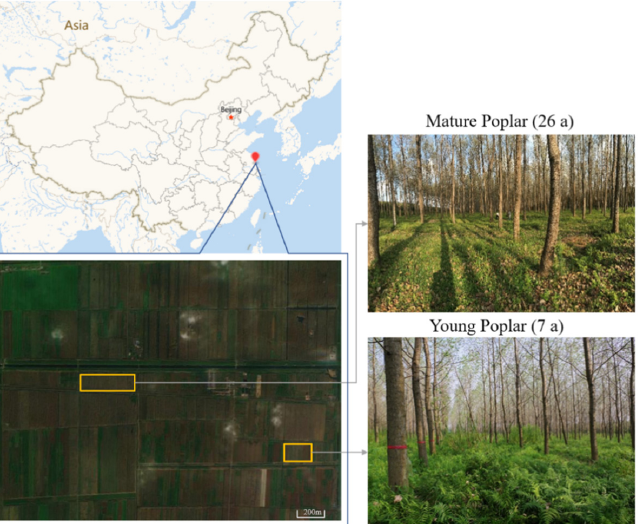
Figure 1. Study location in the eastern coast of China, the satellite image was obtained from 1:4 million China soil type map. Table 1. The stand characteristics in the young (YP) and mature poplar (MP) plantations. Age of